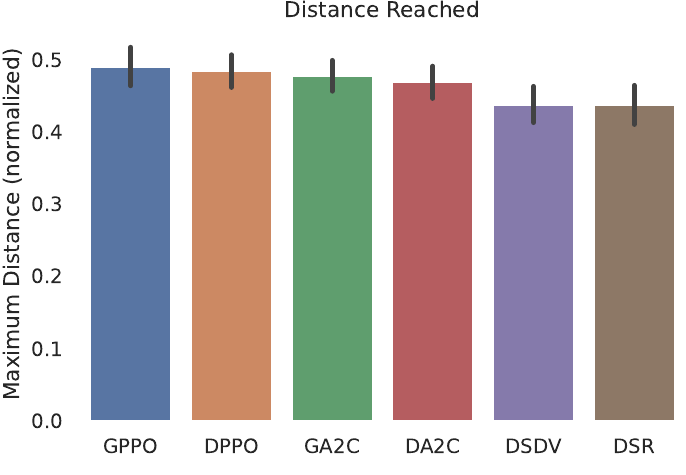
Figure 7. Normalized maximum distance reach of the